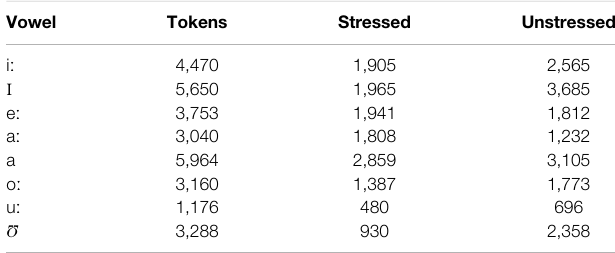
TABLE 1 | Number of tokens per vowel phoneme and primary lexical stress position in the dataset. Vowel Tokens Stressed